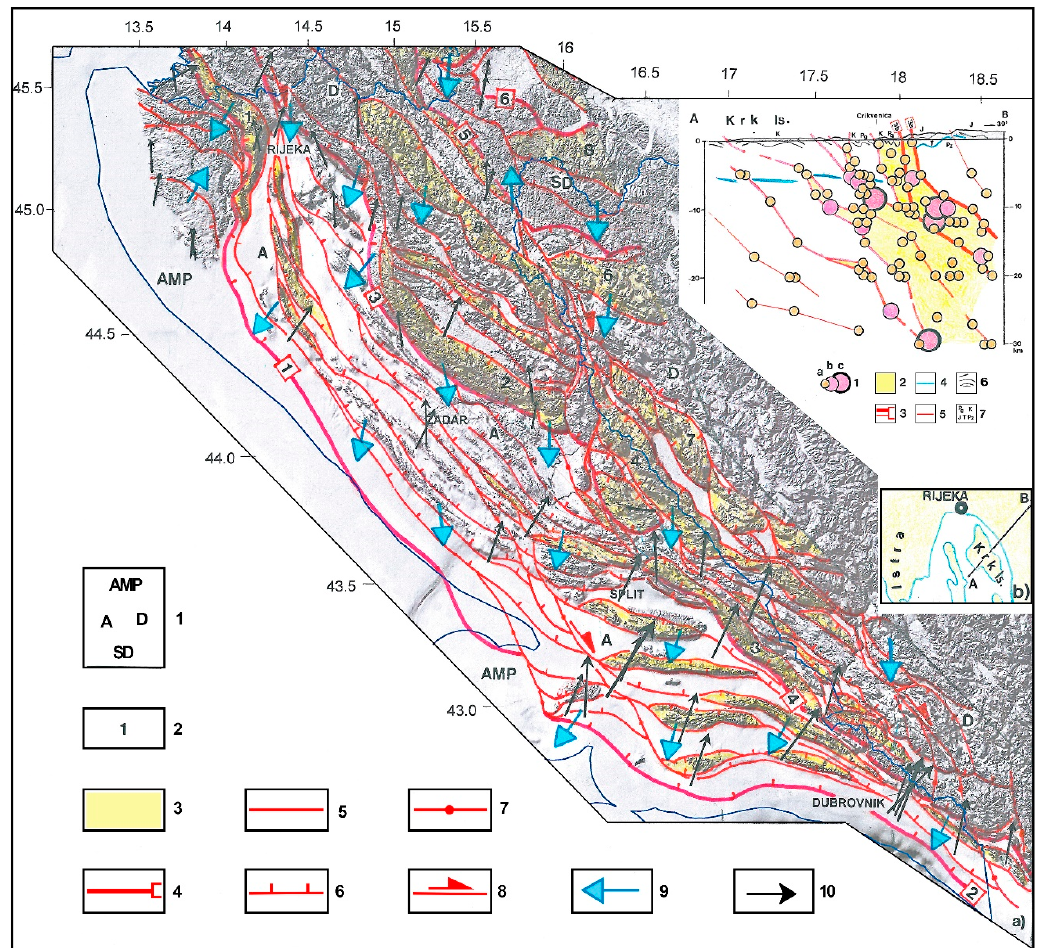
Figure 7. ( a ) Recent geological structural setting and tectonic activity in Dinaric space and Adriatic regional structural unit. Legend: 1—regional geologic structural units: a—Adriatic microplate (AMP) and Adriatic (A) unit, b—Dinarides: Dinaric (D) and Supradinaric (SD); 2—the most prominent structural units within the regional geological structural units with reverse faults of opposite vergence along fault walls: Č i č arija–U č ka (1), Velebit (2), Mosor–Biokovo (3), Dinara– Kamešnica (4), Kapela (5), Grme č (6), Golija (7), Petrova Gora–Kozara (8); 3—major large structures; 4—the most important faults adjacent to regional structural units and parts of the Pannonian Basin, along with the Trieste–U č ka–Vis fault (1), Vis–South Adriatic fault (2), Ilirska Bistrica–Rijeka–Vinodol fault and continuation of Velebit–Sinj fault (3), Mosor–Bio- kovo–Dubrovnik fault (4), Ljubljana–Karlovac–Slunj fault (5), and southern boundary fault of the Pannonian Basin (6); 5— other important faults; 6—reverse faults; 7—faults of indeterminate character; 8—direction of horizontal movement along the fault; 9—direction of movement of structure parts along the surface according to geological data; 10—directions of annual velocity at geodetic points in mm/yr. ( b ) Seismotectonic profile of Rijeka area. Legend: 1—earthquake hypocenters with a magnitude of (a) <4, (b) 4–5, and (c) >5.2; 2—seismotectonically active area; 3—faults included in the seismotecton- ically active areas and the most important Ilirska Bistrica–Rijeka–Vinodol fault (3); 4—other seismotectonically active faults; 5—the probable footwall surface of carbonate rock complex; 6—layers of rocks along the surface; 7—rocks on the surface: Pg (Paleogene)—limestones and flysch; K (Cretaceous)—predominantly limestones and dolomites; J (Jurassic)— limestones and dolomites; T (Triassic)—dolomites, limestones, marls, sandstones, and eruptives; and Pz (Paleozoic)— mainly shale, limestones, conglomerates, and sandstones.